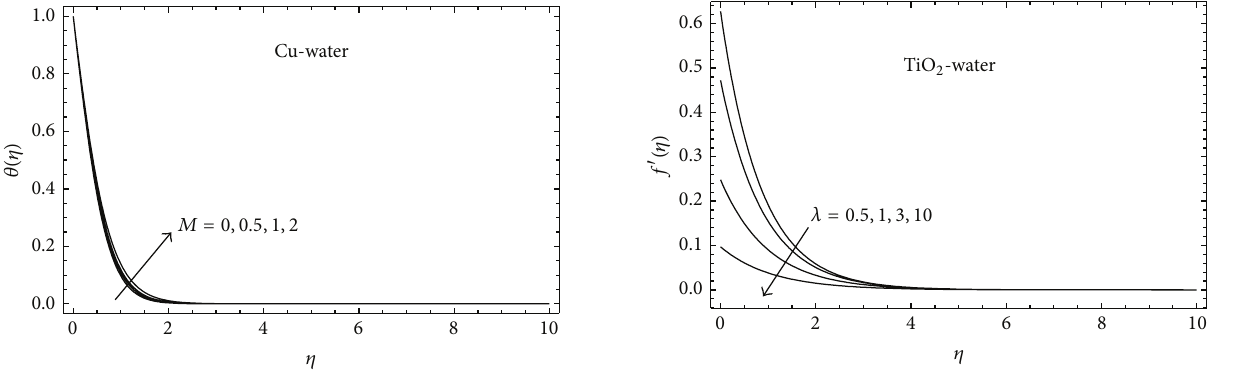
Figure 2: Effect of 𝑀 on temperature distribution 𝜃(𝜂) for Pr = 6.2 and 𝜙 = 0.1 .